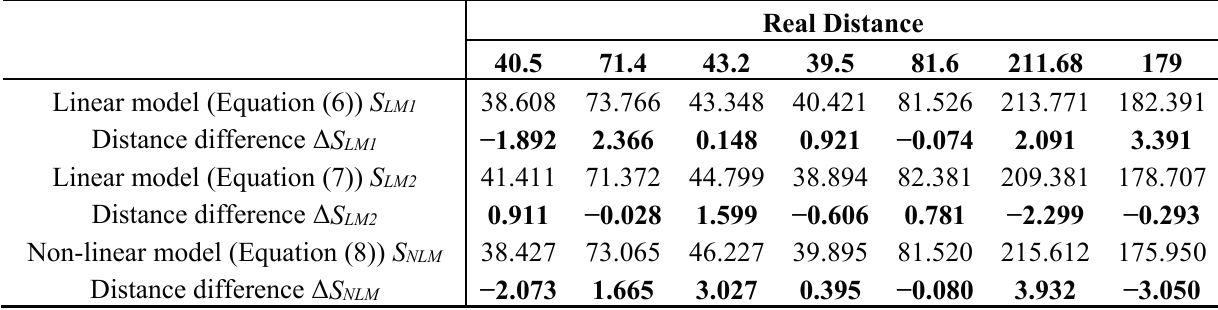
Table 2. Normal gait step length calculation (unit: